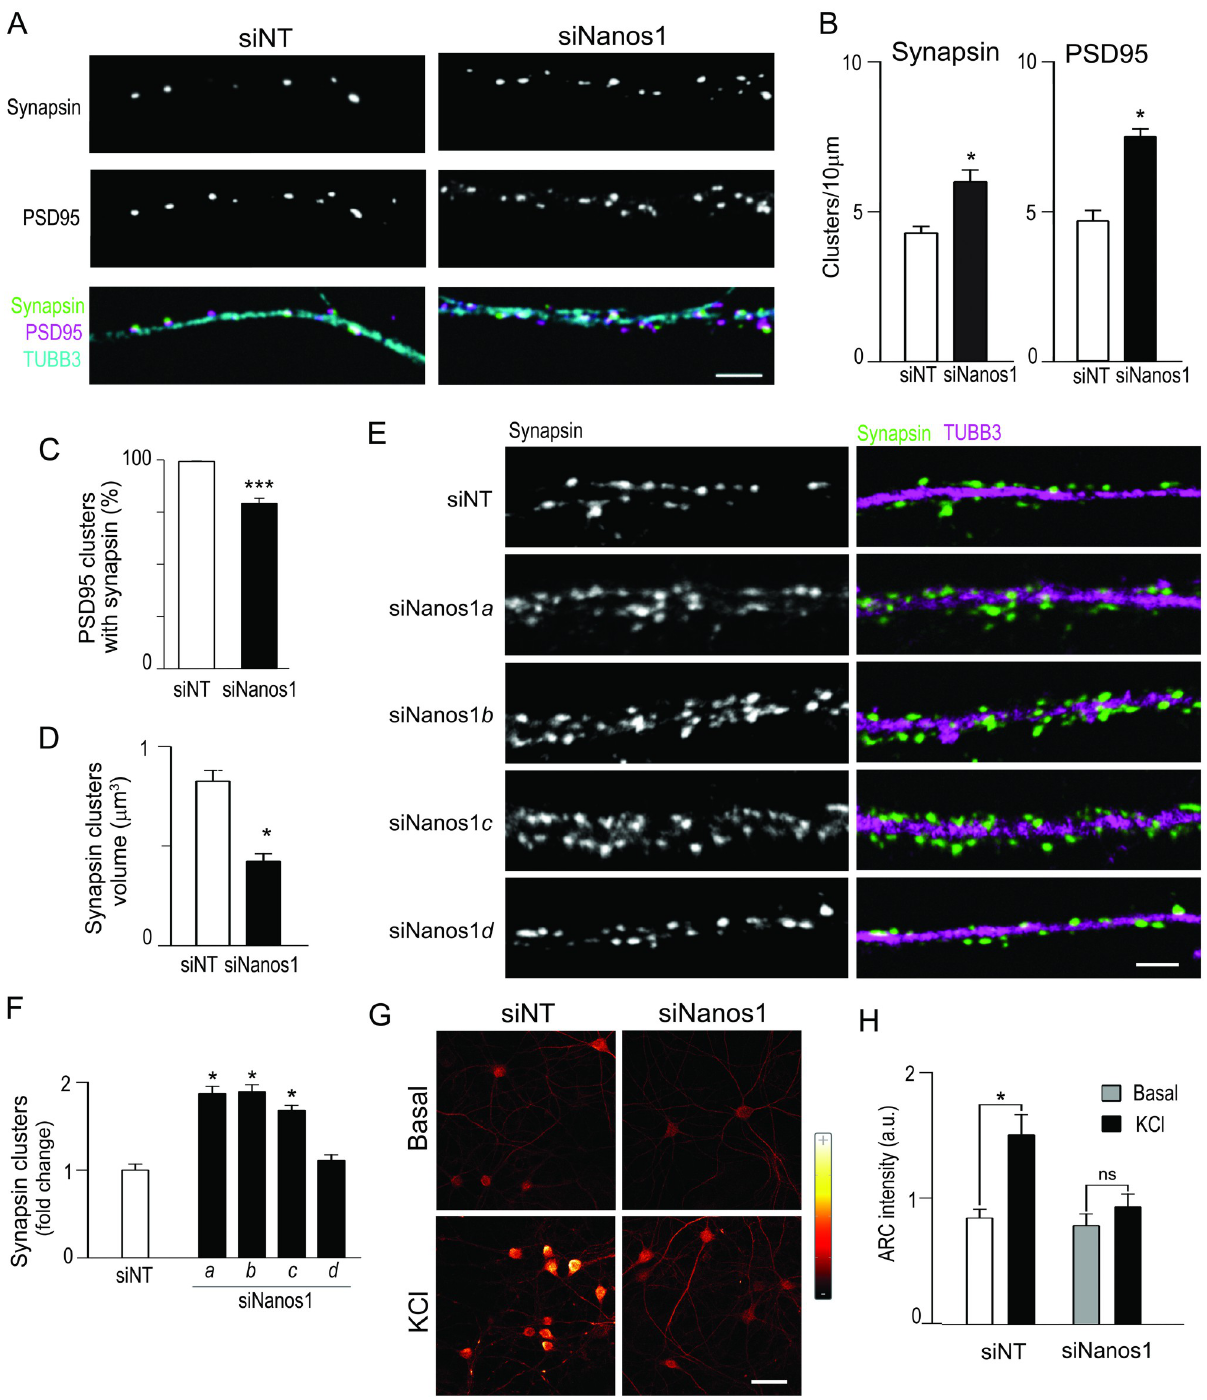
Fig 2. Nanos1 knockdown affects hippocampal synapses and neuron excitability. (A-D) Neurons were treated with the pool of siRNAs against Nanos1 (siNanos1) or with the non-targeting siRNA as in Fig 1, and stained for the indicated synapse markers and TUBB3. Three independent experiments were performed. (A) Representative dendrite fragments. Size bar, 5 μ m. The number of PSD95 or synapsin puncta (B) and the number of PSD95 puncta with a cognate synapsin cluster (C) were analyzed in 10 randomly-selected neurons with a total dendritic length of 4389 μ m (siNT) and 5174 μ m (siNanos1). (D) The average volume of the synapsin clusters was determined as indicated in Materials and Methods. (E, F) Neurons were treated with each one of the four dsRNA present in the pool used in Fig 2A-2D. (E) Representative dendrite fragments stained for synapsin and TUBB3 are shown. Size bar, 5 μ m. (F) The number of synapsin puncta was measured in randomly selected dendritic fragments from three independent cultures, with a total dendritic length of 562 μ m (siNT); 793 μ m (siNanos1 a ); 642 μ m (si Nanos1 b ); 590 μ m (si Nanos1 c ) and 739 μ m (si Nanos1 d ). * p < 0.05; ***